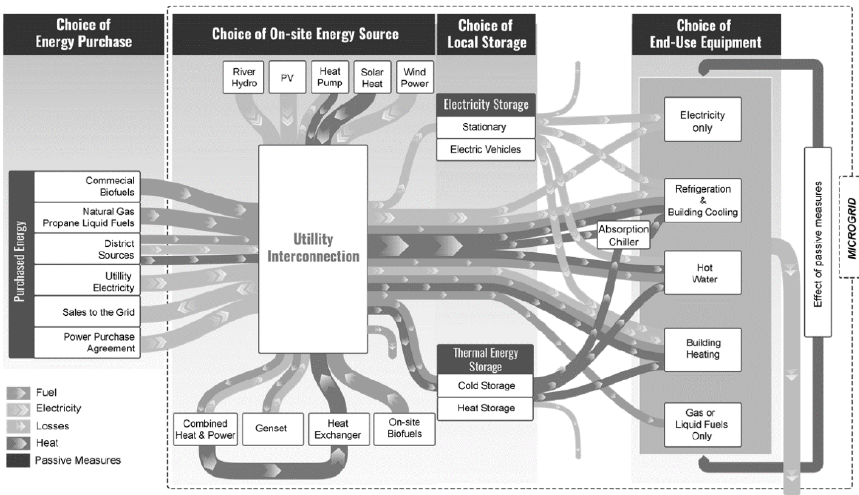
Figure 2. Sankey diagram for the Microgrid DER-CAM/XENDEE MILP. The five energy end-uses on